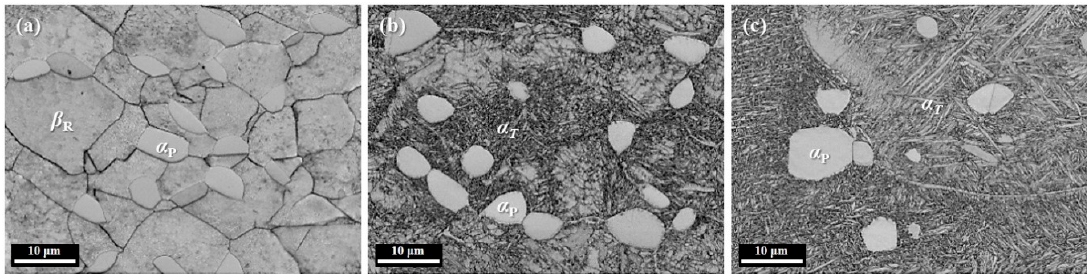
Figure 2. SEM images of Ti-5Al-3.5Fe alloy. ( a ) Initially, ( b ) after aging for 10 h, and ( c ) after aging for 100 h, at 500 °C; α P : primary α phase; β R : retained β phase; α T : α phase transformed from retained β phase.